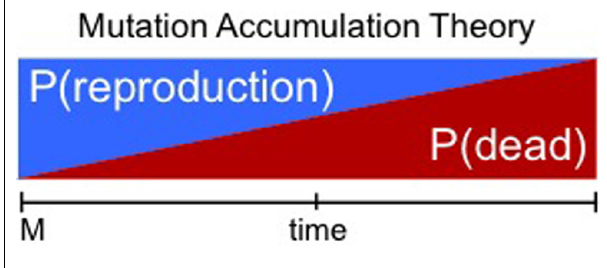
FIGURE 2 | Maladaptive aging theories. Illustration of “Mutation AccumulationTheory.” Here the probability of an individual being dead (P(dead), red) increases over time solely due to harsh extrinsic mortality. Consequently the likelihood of successful reproduction (P(reproduction)) at any given time decreases over time (blue).The increasing probability of being dead acts as the main force restricting the selection for longer lifespan. It is reasonable to assume that there is no selective pressure for longevity after a certain threshold at which the likelihood of reproducing is very low. In this case the fitness associated with extended lifespan is neutral. Here death is supposed to occur before senescence has an effect, thus senescence is not necessary to affect the probability of death. M,